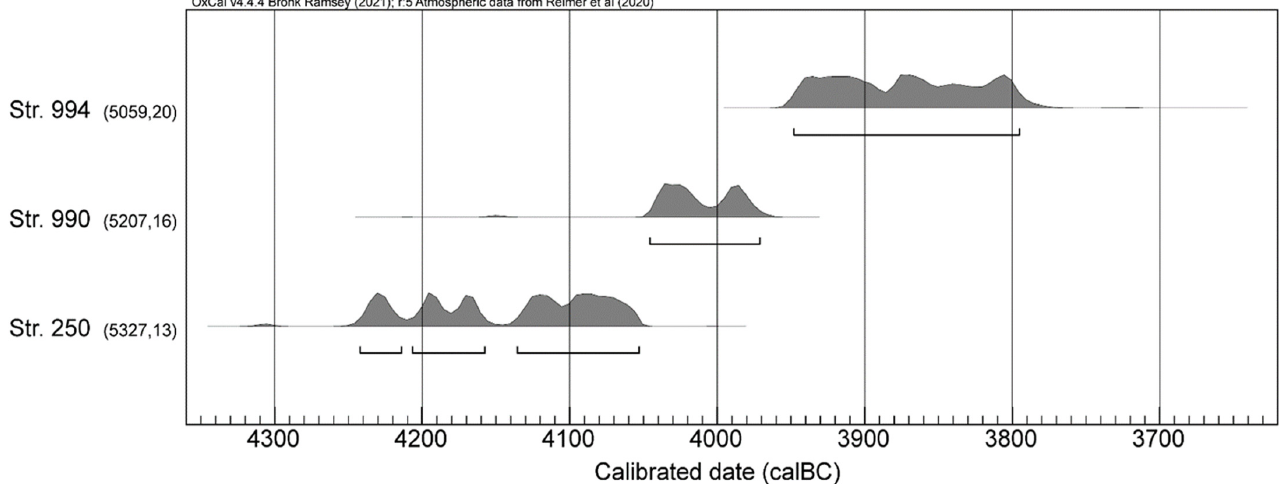
Figure 3. Single plots of the contemporaneity test results for the well 250, 990, and 994. Calibration with OxCal v4.4.4 [80]) and IntCal20 atmospheric curve [81].